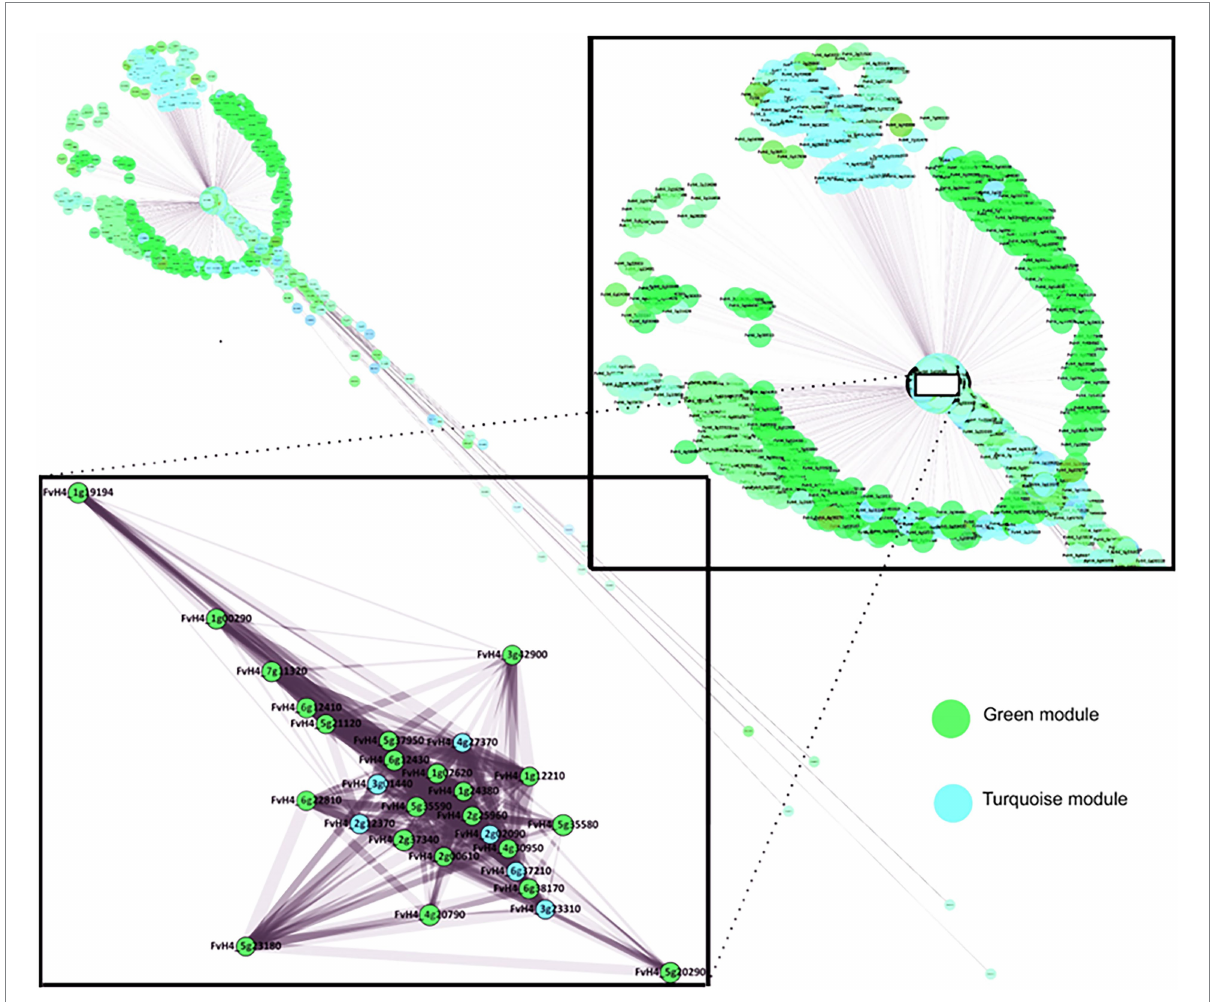
FIGURE 12 Weighted gene co-expression network for firmness of Mara des Bois strawberries at 20 ° C controlled by high CO 2 . Network for the genes co- expressed in turquoise and green modules which have a high weight over firmness. The inverse relationship clusters connecting fruit firmness with biotic stress and involving cell wall homeostasis are occupying a central place in the gene expression network. The close-up is highlighted a representative group of genes for both modules analyzed by